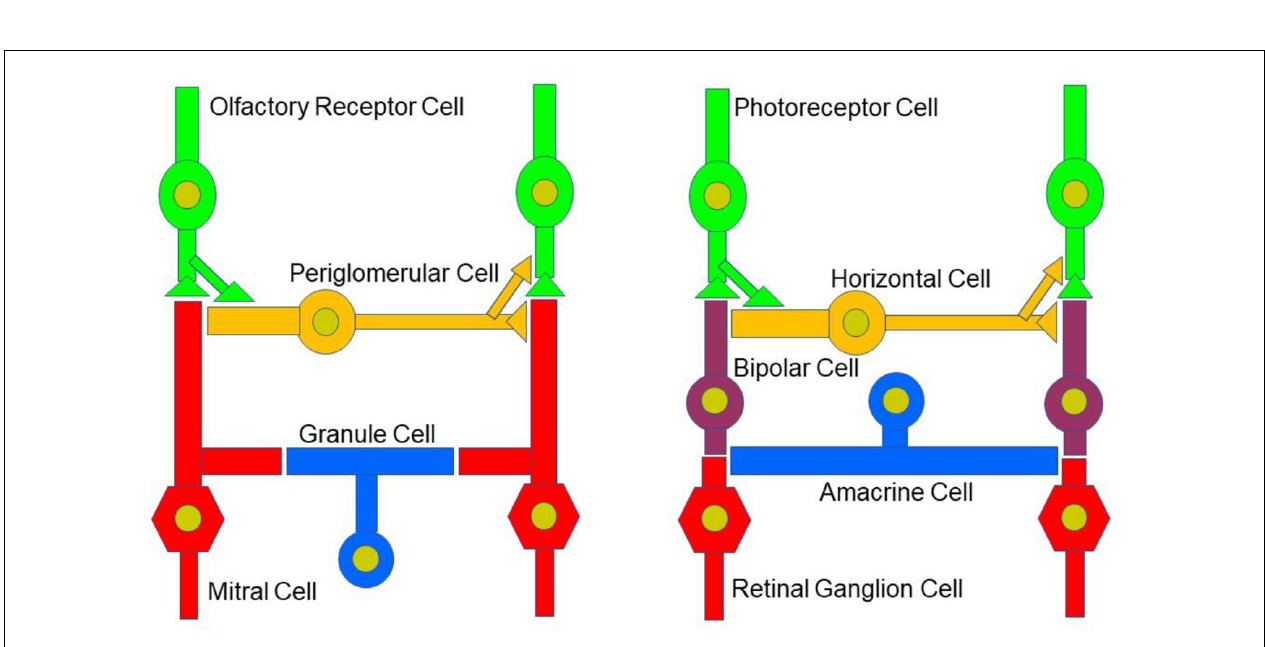
FIGURE 2 | Neural circuitry in the early olfactory and visual system. Early sensory processing engages similar circuit mechanisms in both systems and can be depicted in a similar